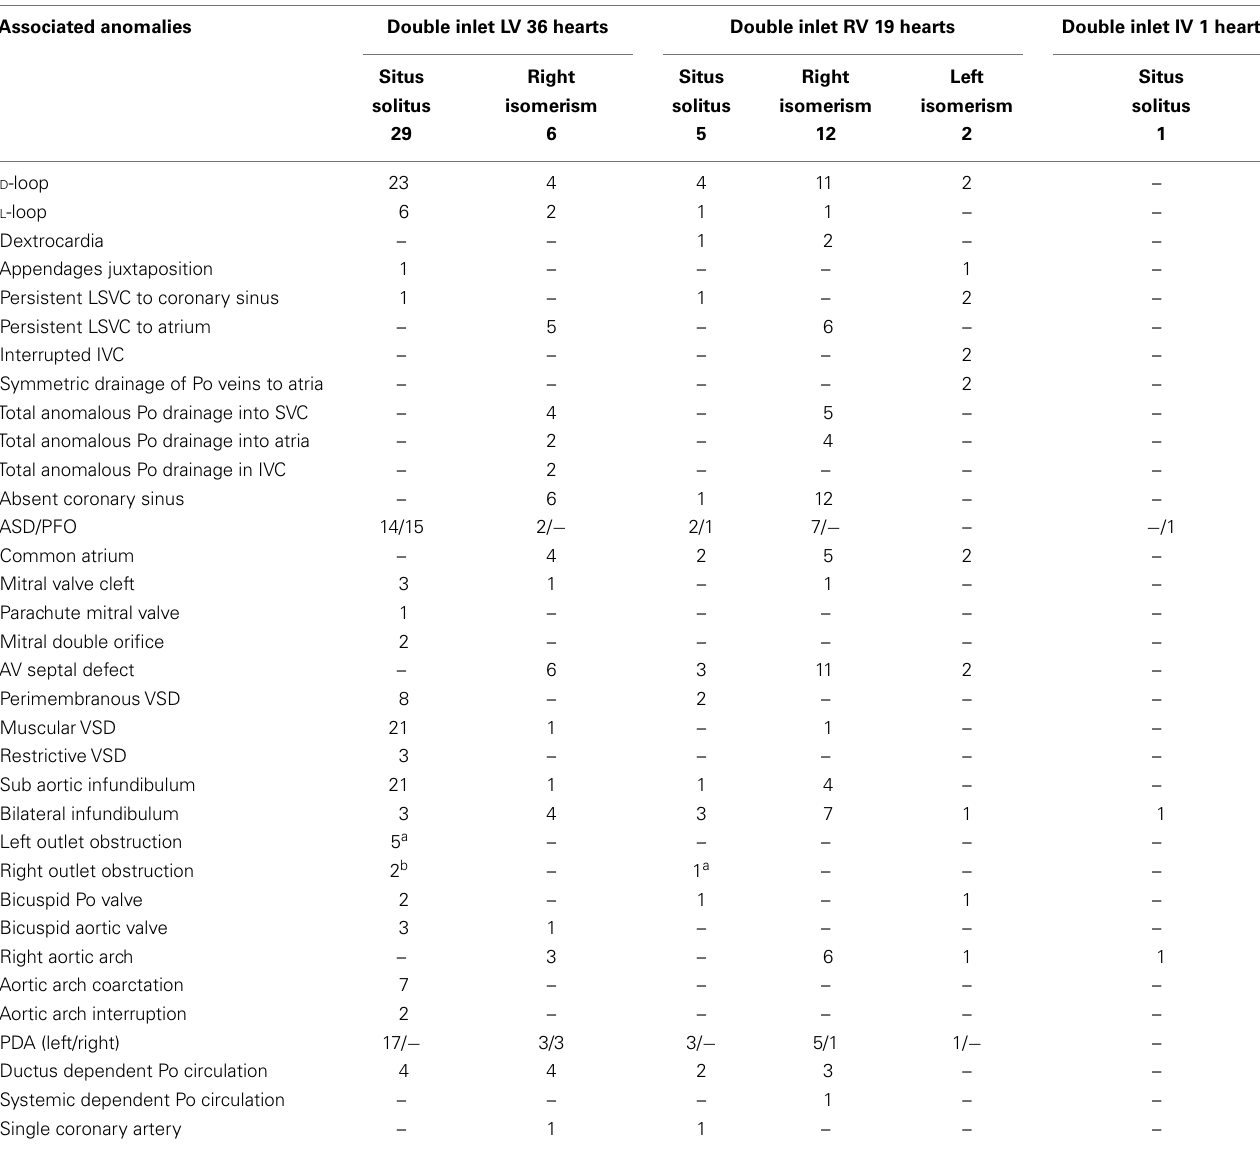
Table 4 | Double inlet ventricle: associated anomalies